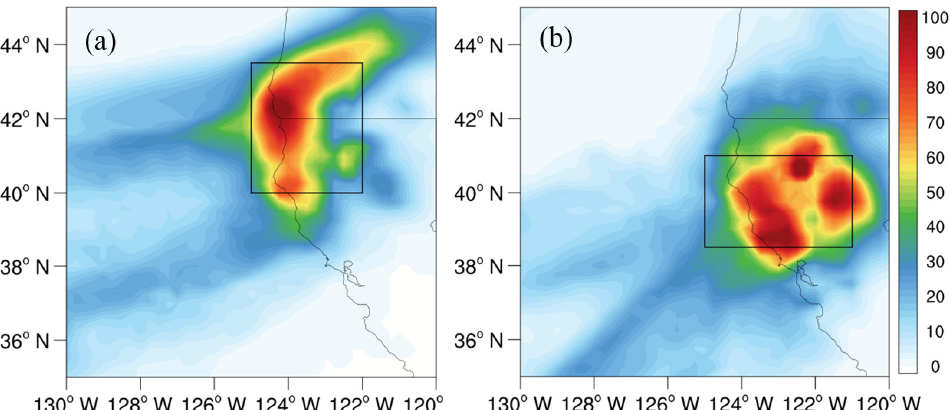
Figure 3. The distribution of the 24-h accumulated precipitation: ( a ) during Stage I (from 25 February 00:00 UTC, to 26 February 00:00 UTC) and ( b ) during Stage II (from 26 February 12:00 UTC, to 27 February 12:00 UTC). The heavy rain area is marked by the box: ( a ) Stage I and ( b ) Stage II.